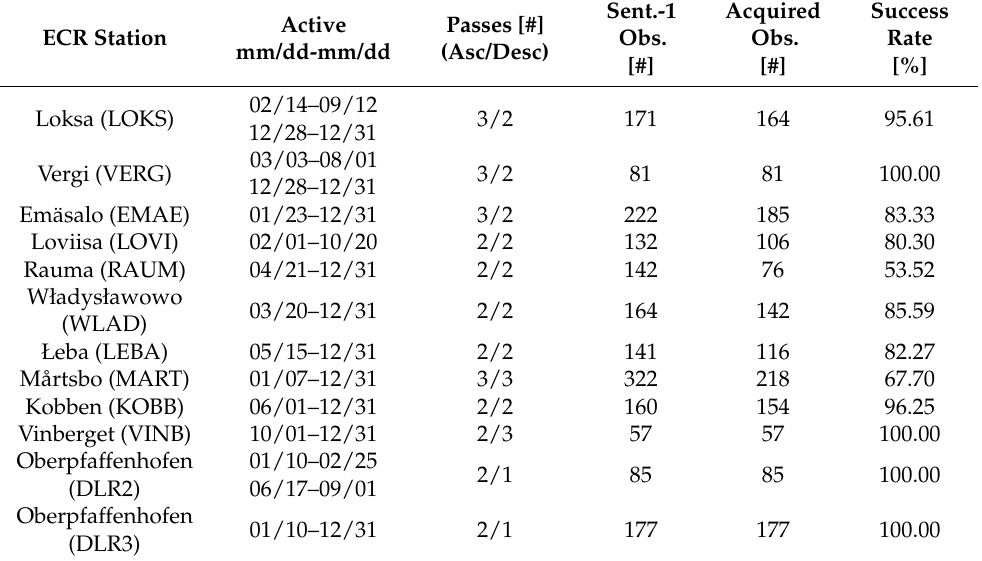
Table 1. Summary on SAR data collected in 2020 within the project’s ECR network. Active periods are the times the ECRs operated successfully. Passes list the number of repeat pass geometries acquired by Sentinel-1 in ascending and descending orientation at a respective site. Sentinel-1 observations refer to the number of SAR images available in the catalogue whereas acquired observations list successful ECR activations with full performance signals in the SAR data. For the station map, refer to Figure